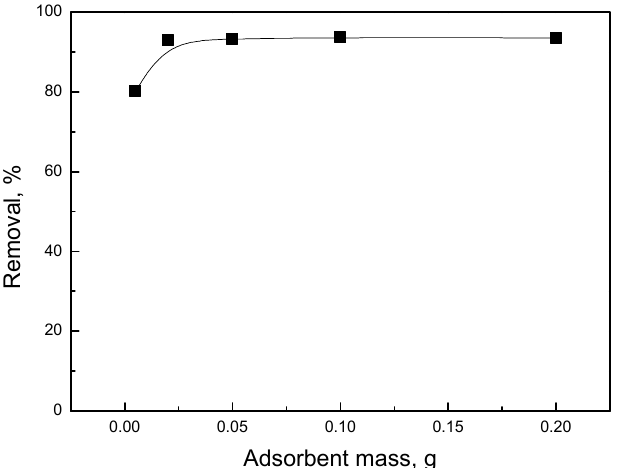
Figure 5. Mercury removal rate of activated biochar with different masses.